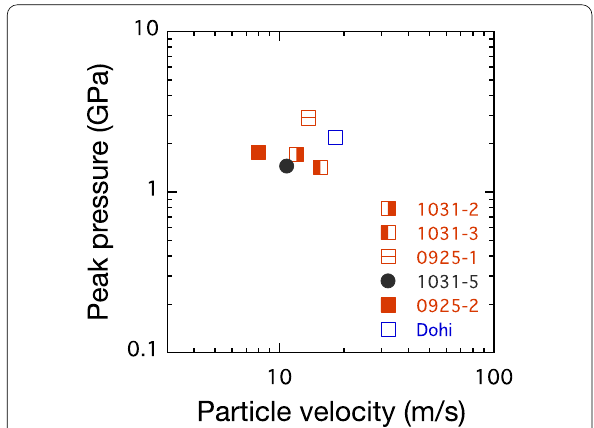
Fig. 9 Peak pressure and particle velocity corresponding to the experimental results of crater depth and radius. The results of 0925-2 and one of the shots in Dohi et al. (2012) (090528-1) are also